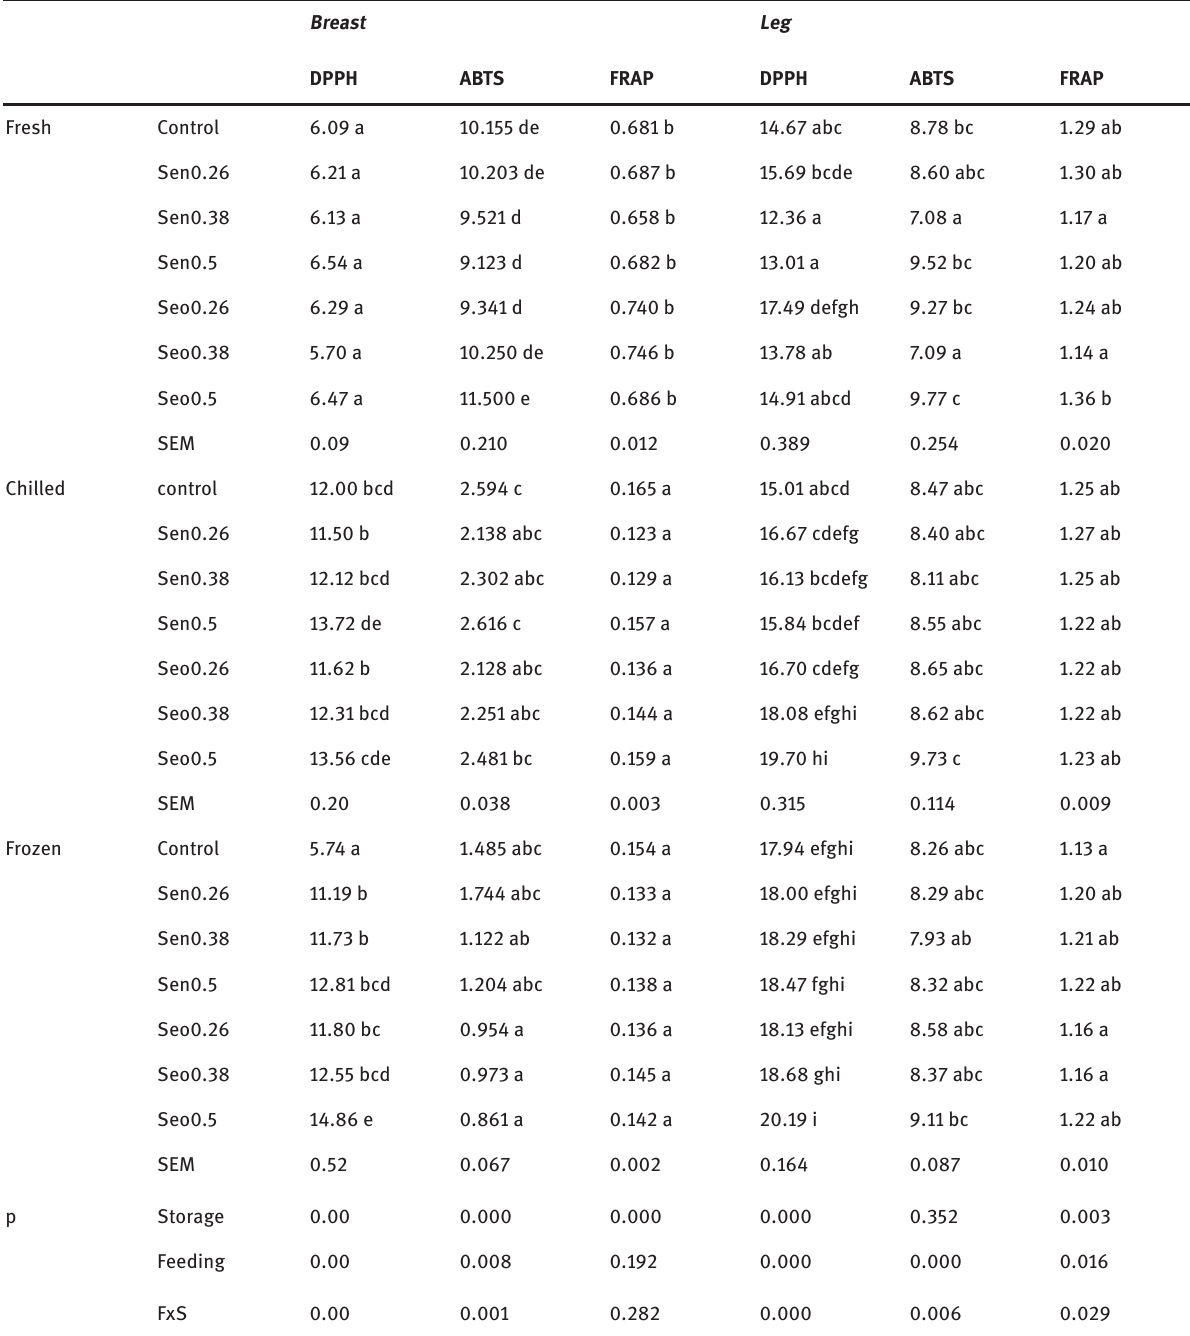
Table 2: Total antioxidative status of breast and leg chicken muscles after dietary modulation with selenium